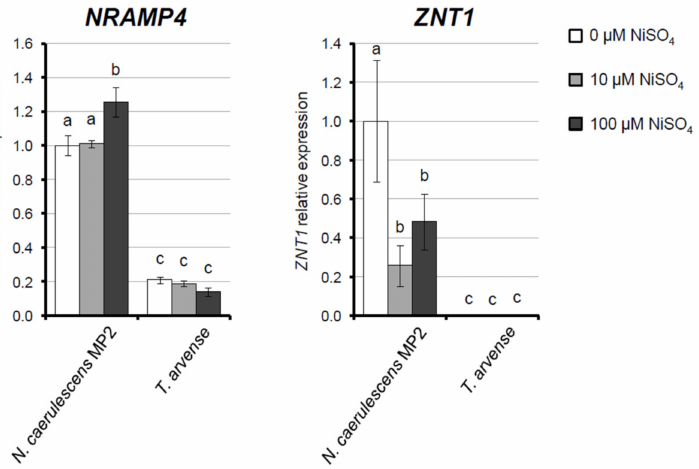
Figure 1. Expression profiles of NRAMP4 and ZNT1 tested in leaves of the Ni hyperaccumulator Noccaea caerulescens MP (population MP2) and of the non-accumulator Thlaspi arvense, both grown in hydroponic culture in the absence (white bars) or presence of 10 µ M (grey bars) and 100 µ M (black bars) NiSO 4 for 24 h. The expression level of NRAMP4 and ZNT1 is expressed as relative expression on internal reference genes actin 2, 8, and ubiquitin 10 according to the Livak—Schmittgen 2 − ∆∆ CT method. Statistically significant variations, as resulting from the ANOVA test ( n = 3) followed by a post hoc Tukey’s test, at p < 0.05, are marked by different letters. Bars correspond to standard